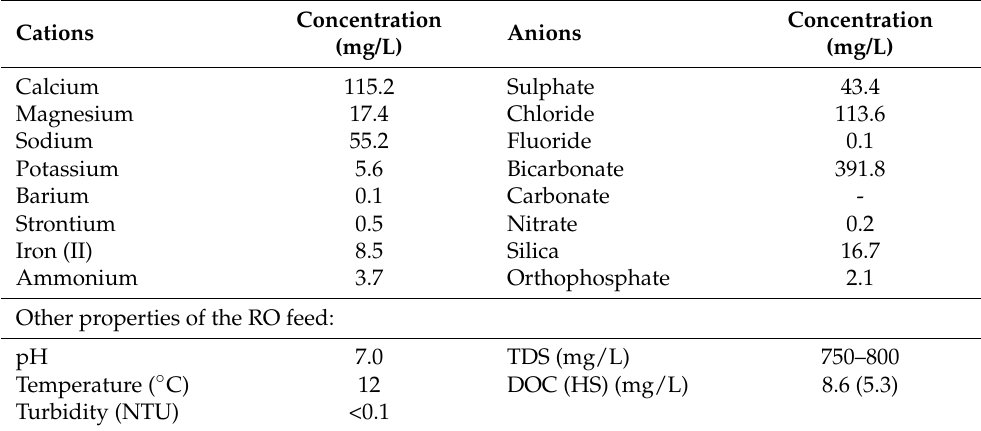
Table 1. Feedwater (anaerobic GW) composition.